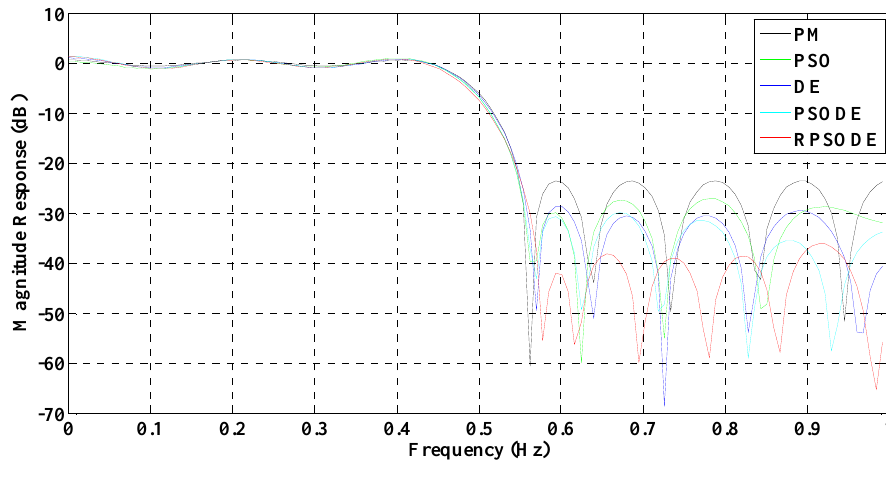
Figure 3: dB plots for the FIR HP filter of order